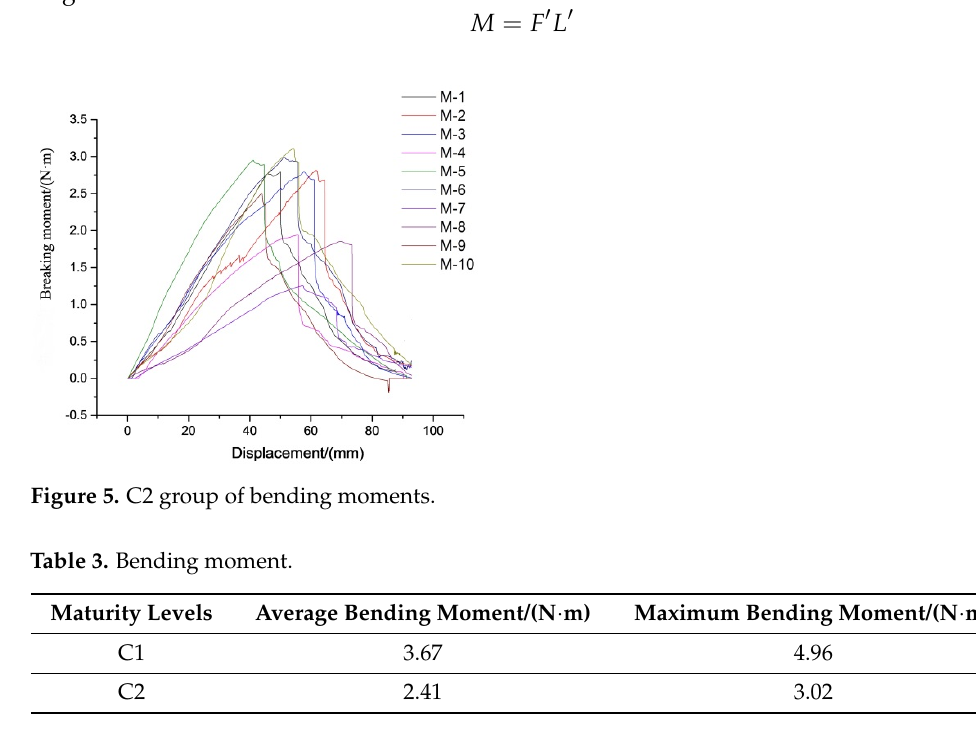
Figure 6. Multi-flexible-fingered roller of pineapple harvester. 1. Right flexible finger 2. Left flexible finger 3. Gear 4. Roller 5. Leaf press shelf.